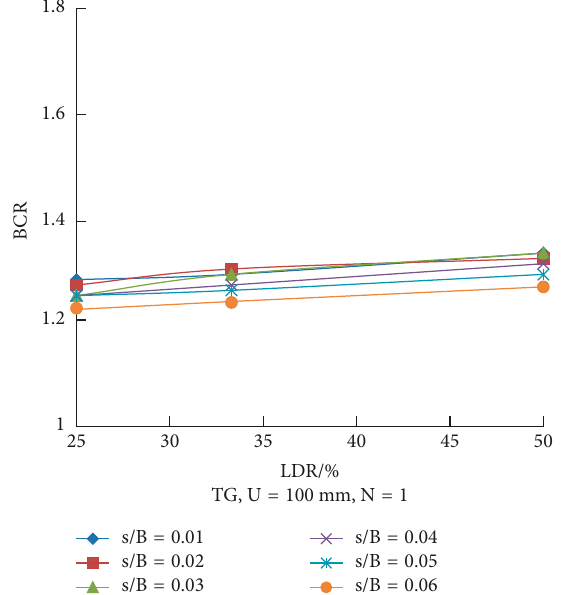
Figure 9: The relationship between BCR and U (TG; LDR N 1). (cid:30)